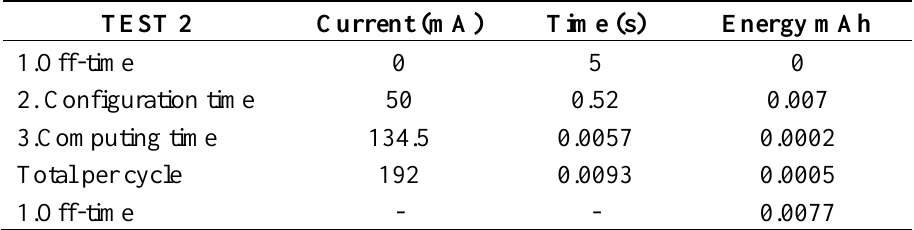
Table 6. Resource utilization of the different Encryption Algorithms.